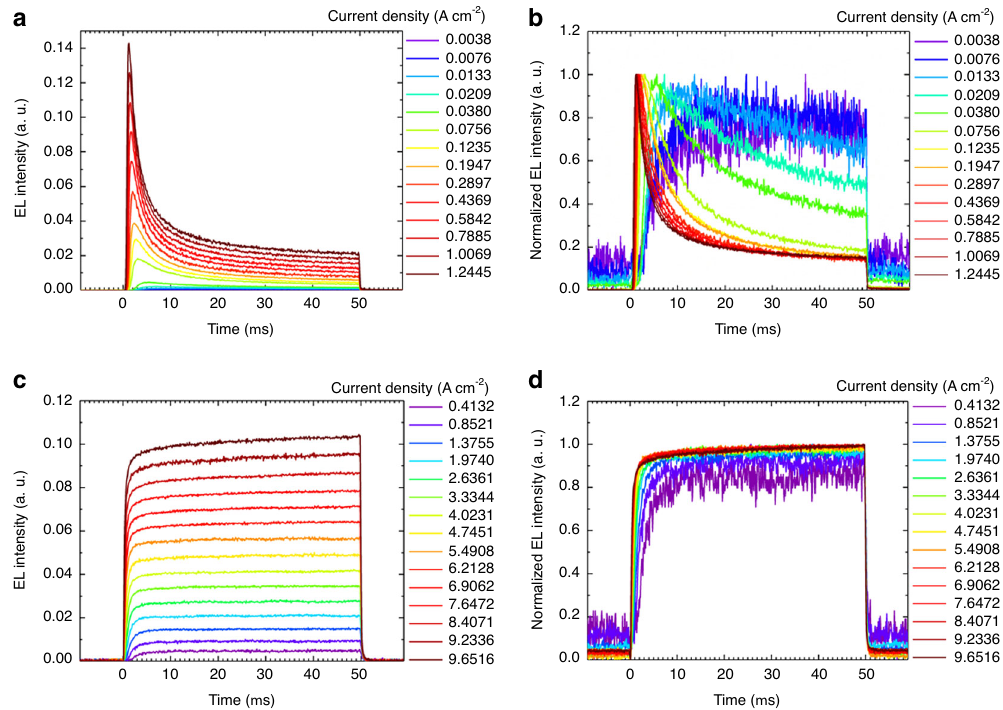
Fig. 5 Transient EL responses of OLEDs. a , b When the host is CBP for device A or c , d when the host is BSBCz for device C, which were measured at different current densities with a pulse width of 50 µ s. For ( b ) and ( d ) respectively, the EL intensities were normalized to make it easy to see the response shapes. The EL intensity from OLEDs were recorded using a photomultiplier tube (PMT) (C9525-02, Hamamatsu Photonics) for the measurement of temporal emission pro fi